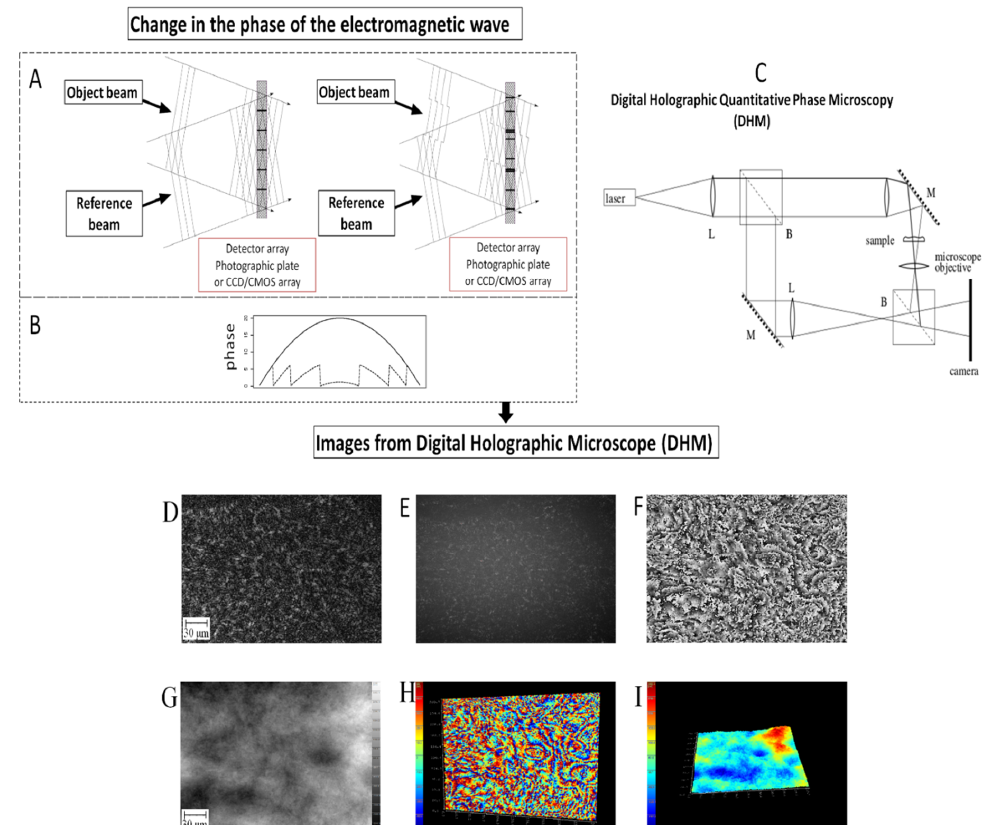
Figure 5. Digital holographic microscopy. ( A )—left: the interference pattern from a plane reference beam and a plane object beam; right: when part of the wave-front of the object beam is shifted due to depth differences in the object, the interference pattern is changed: depth distances are encoded in the hologram registered by the detector; ( B )—the dashed line is the wrapped phase along a line across a sample; the full line is the result of unwrapping and is a measure of the optical thickness along this line; ( C )—optical scheme of a digital holographic transmission microscope; L=lens, B=beam-splitter, M=mirror; ( D )—an intensity image, as in classical optical microscope with monochromatic illumination; ( E )—hologram; ( F )—wrapped phase image; ( G )—unwrapped phase image; ( H )—3D representation of ( F ); ( I )—3D representation of ( G ).